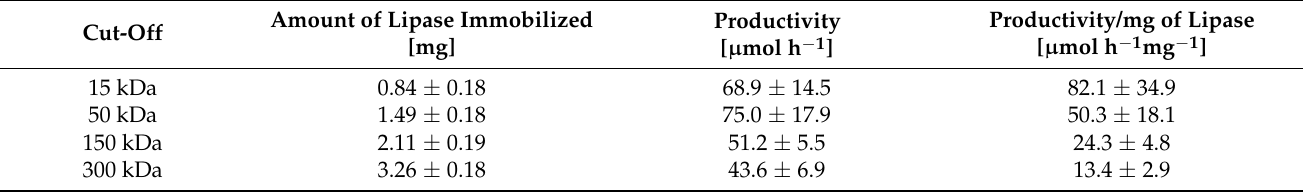
Table 3. Results of determination of lipase activity in enzyme membranes depending on mem- brane